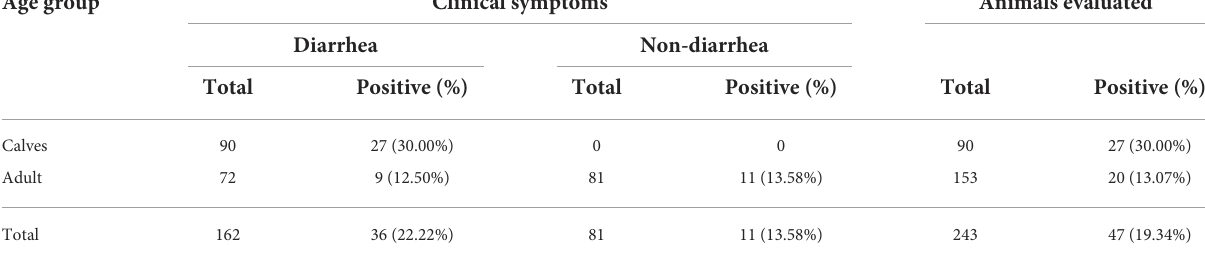
TABLE 4 BKV detection results of clinical samples by the developed real-time RT-PCR. Age